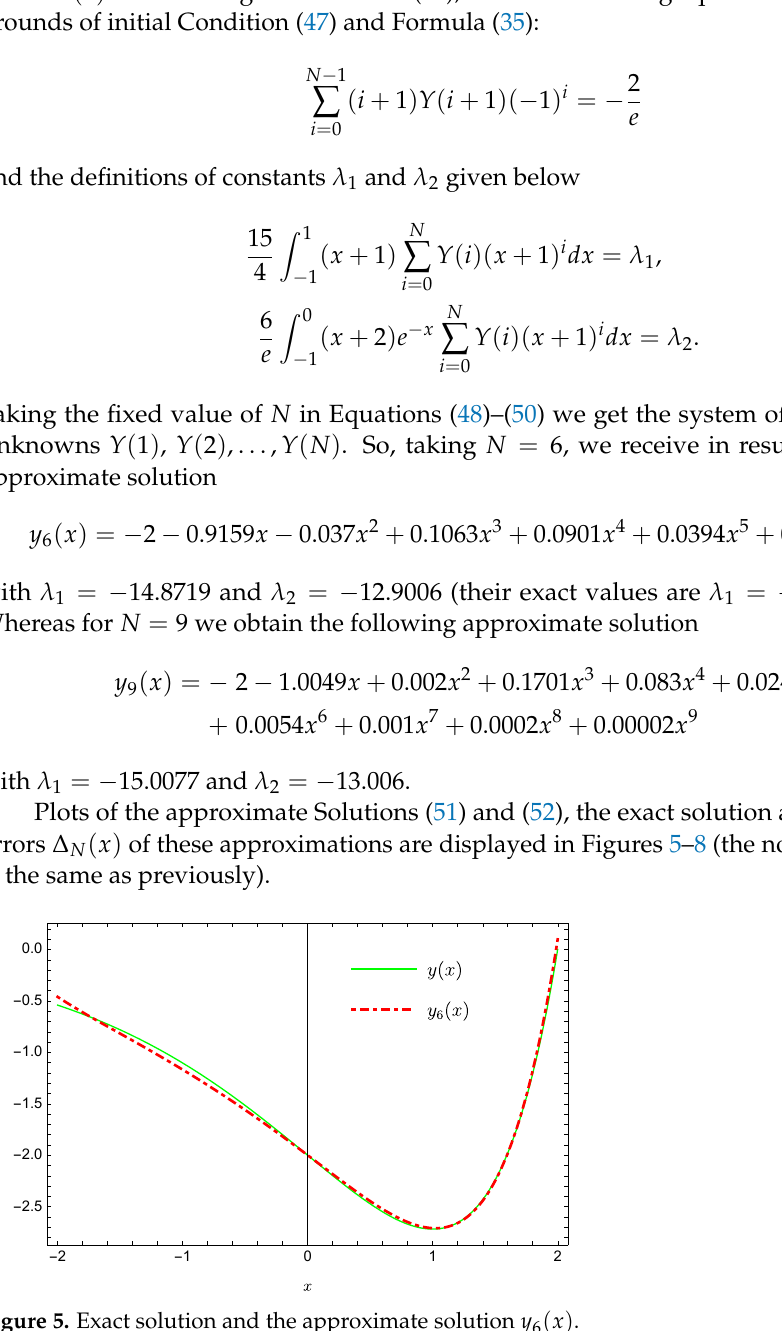
Figure 5. Exact solution and the approximate solution y 6 ( x )